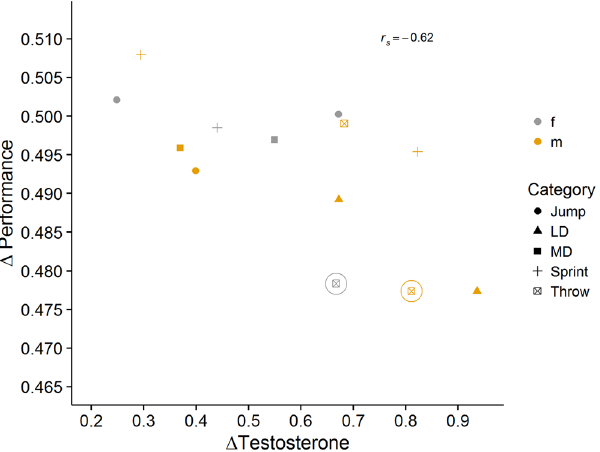
Figure 4. Correlation of testosterone change prior to competition, Δ T (X-axis) and performance; Δ P (Y-axis). Each symbol represents an individual athlete; color indicates sex of the athlete, shape indicates the category the athlete started in, LD = long distance running, MD = middle distance running, Jump = jumps, Sprint = sprints, Throw = throws. Athletes marked with a circle were less involved in competitive athletics than the other